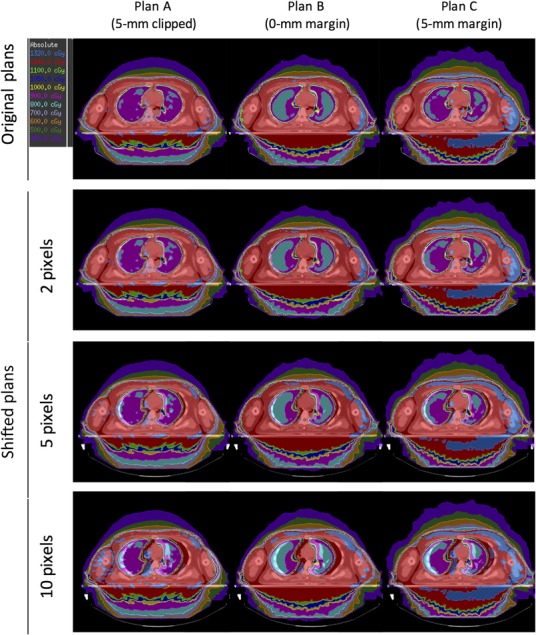
Examples of dose distributions. In Plan C, the area just under the skin surface tends to receive a high irradiation dose. When CT images are shifted to the left side, the body is exposed to a high-fluence beam and the high-dose area is enlarged.